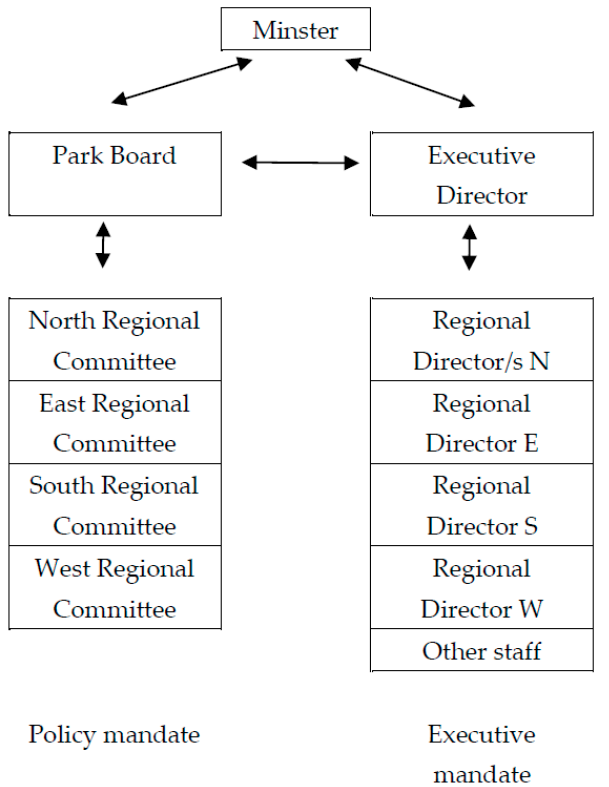
Figure 4. The organisational structure of the co-management system of VNP. At the central government level, VNP’s administration falls within the remit of the Ministry for the Environment and Natural Resources. The official funding for the park comes from the government’s central budget via this ministry. It has a defined Park Board with seven representatives, including two representatives from the central government, four from local governments and one from environmental civil society. Representatives from recreation and tourism civil society have observer status at the Park Board. The Min- ister is given the role to appoint the Chairman of the Board and the Vice-Chair. The Min- ster further appoints the Executive Director after recommendations from the Park Board, who holds the status of a public official. The regional Park directors are also state employ- ees, under the supervision of the Executive Director. They are, however recruited, after recommendations from the respective regional councils. Within each regional council, the local governments have three representatives, one of whom constitutes the chair. The respective local government chairs in the four regional councils are nominated as the four local government members on the Park Board. The local governments are therefore given substantial formal power in the actor structure in the legislation, having the majority of the votes on the Park Board with four representa- tives out of seven and the majority on the regional councils. The civil society has three representatives on each regional council, representing en- vironment, and recreation and economic actors representing tourism. The civil society also has a member on the Park Board, representing the environmental sector, while the recreational sector and tourism sector has only a member without voting rights. Although the co-management structure is inclusive of local governments and some civil society actors, we found some dissatisfaction around these membership arrange- ments. The membership concerns were mainly from the civil society actors that have full